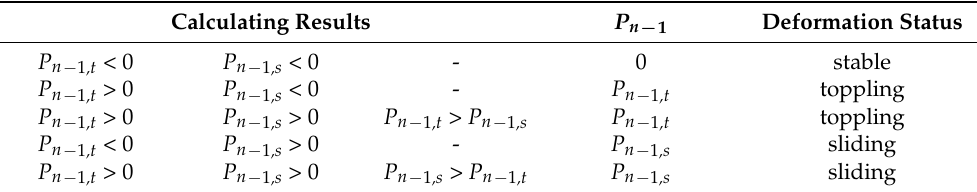
Table 1. Determination of the P n − 1 and deformation status of the n th block.